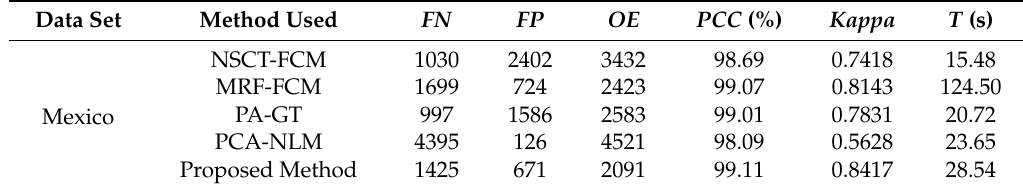
Table 3. Multi-spectral image change detection results under evaluation by different algorithms.